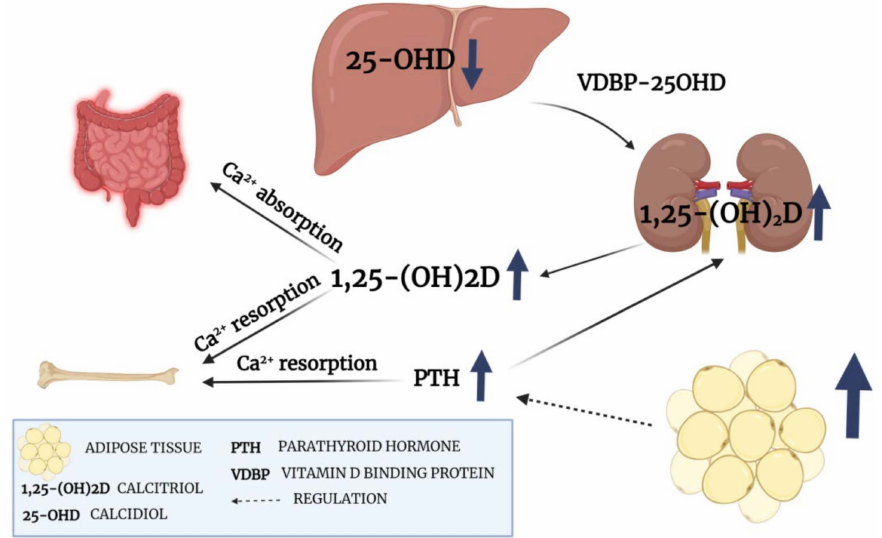
Figure 2. PTH-vitamin D metabolism axis (created with